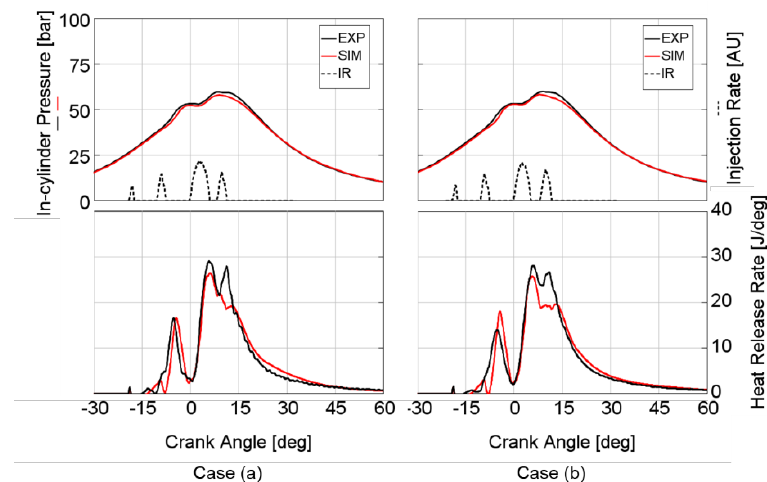
Figure 16. E ff ect of post injection ET–Top: simulated (red) vs. experimental (black) in-cylinder pressure, Figure 16. Effect of post injection ET – Top: simulated (red) vs experimental (black) in-cylinder injection rate (dashed black). Bottom: simulated (red) vs. experimental (black) Heat Release Rate. WP: pressure, injection rate (dashed black). Bottom: simulated (red) vs experimental (black) Heat Release 1500 rpm × 5.0 bar BMEP–Case (a) and (b). Rate. WP: 1500 rpm x 5.0 bar BMEP – Case a) and b).